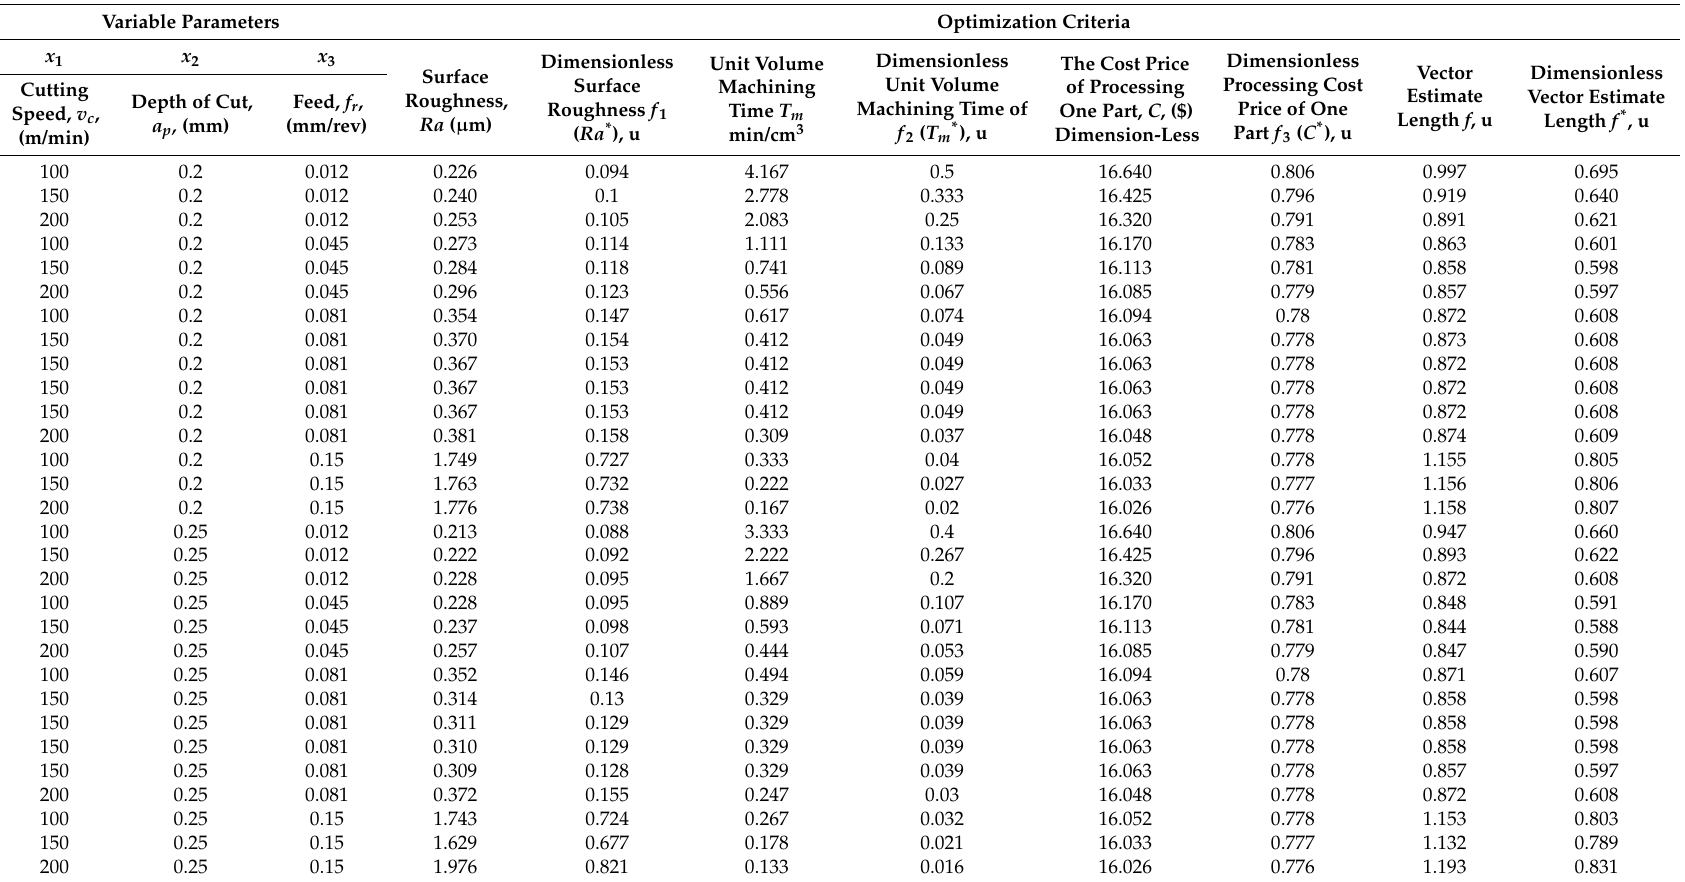
Table 7. A selection of the optimization criteria parameter value set for the variable machining parameters of a workpiece hardened with ECAP-4. Variable